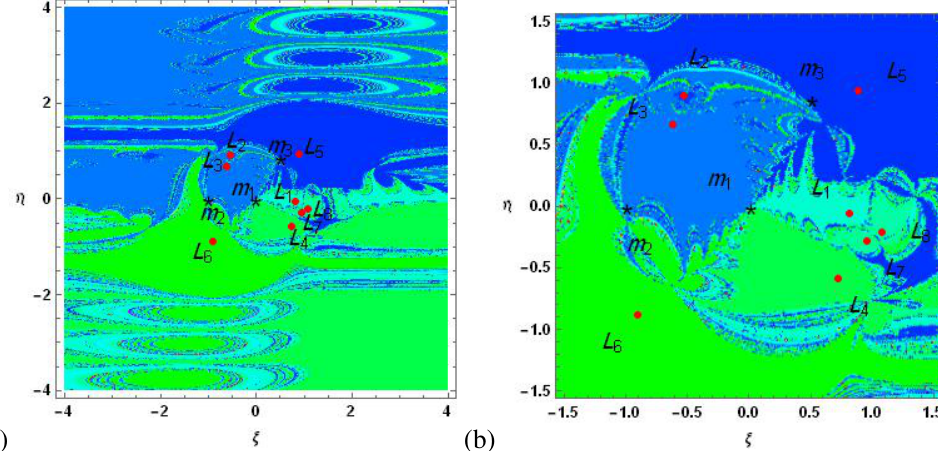
Fig. 10 (a): The basin of attraction for the oblateness case. (b): Zoomed image of (a) near the lagrangian